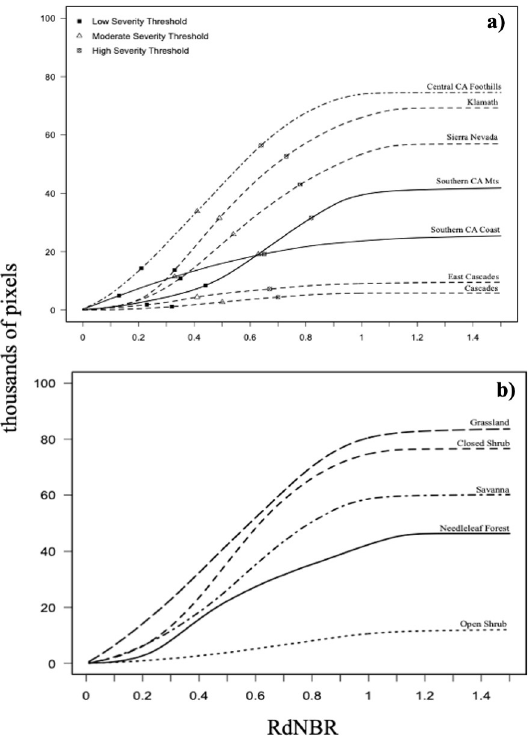
Fig 4. Histograms for RdNBR averaged for the entire study period of 2003–2020. Symbols mark the lower limits of low, moderate, and high burn severity class respectively; (a) RdNBR by ecoregion, and (b) RdNBR by individual vegetation type. Burn severity thresholds for each ecoregion were calculated from the cumulative frequency distribution of RdNBR pixel values (see Methods).